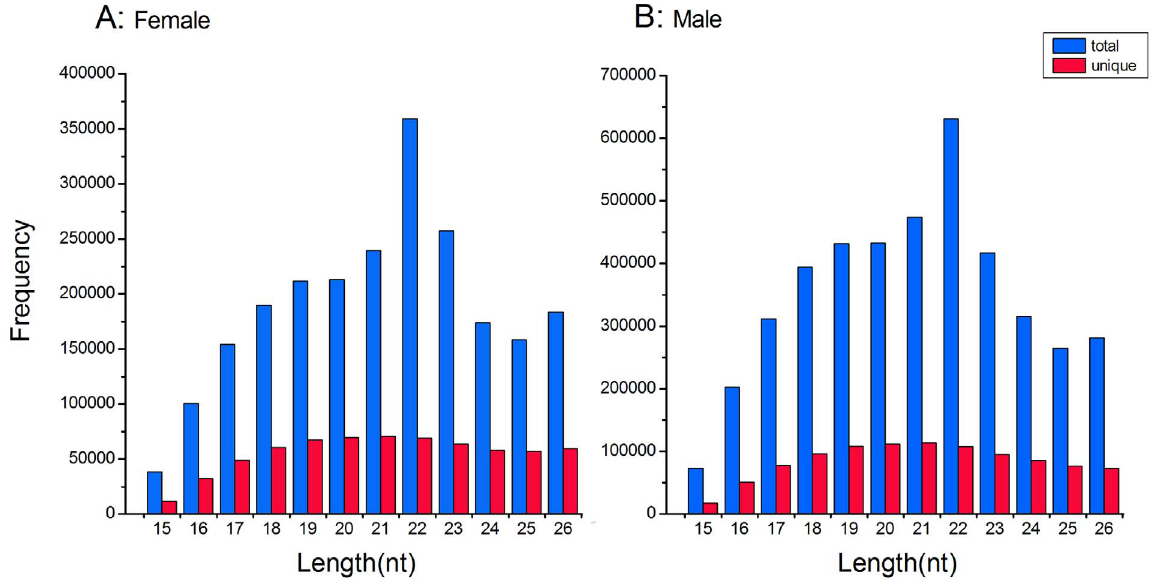
Figure 2. Size distribution of mappable reads related to miRNA in the female (A) and male (B) libraries of E.sinensis . The total represents the number of all mappable sequences were marked blue, and the unique represents the number of unique sequences were marked red. nt, nucleotides.